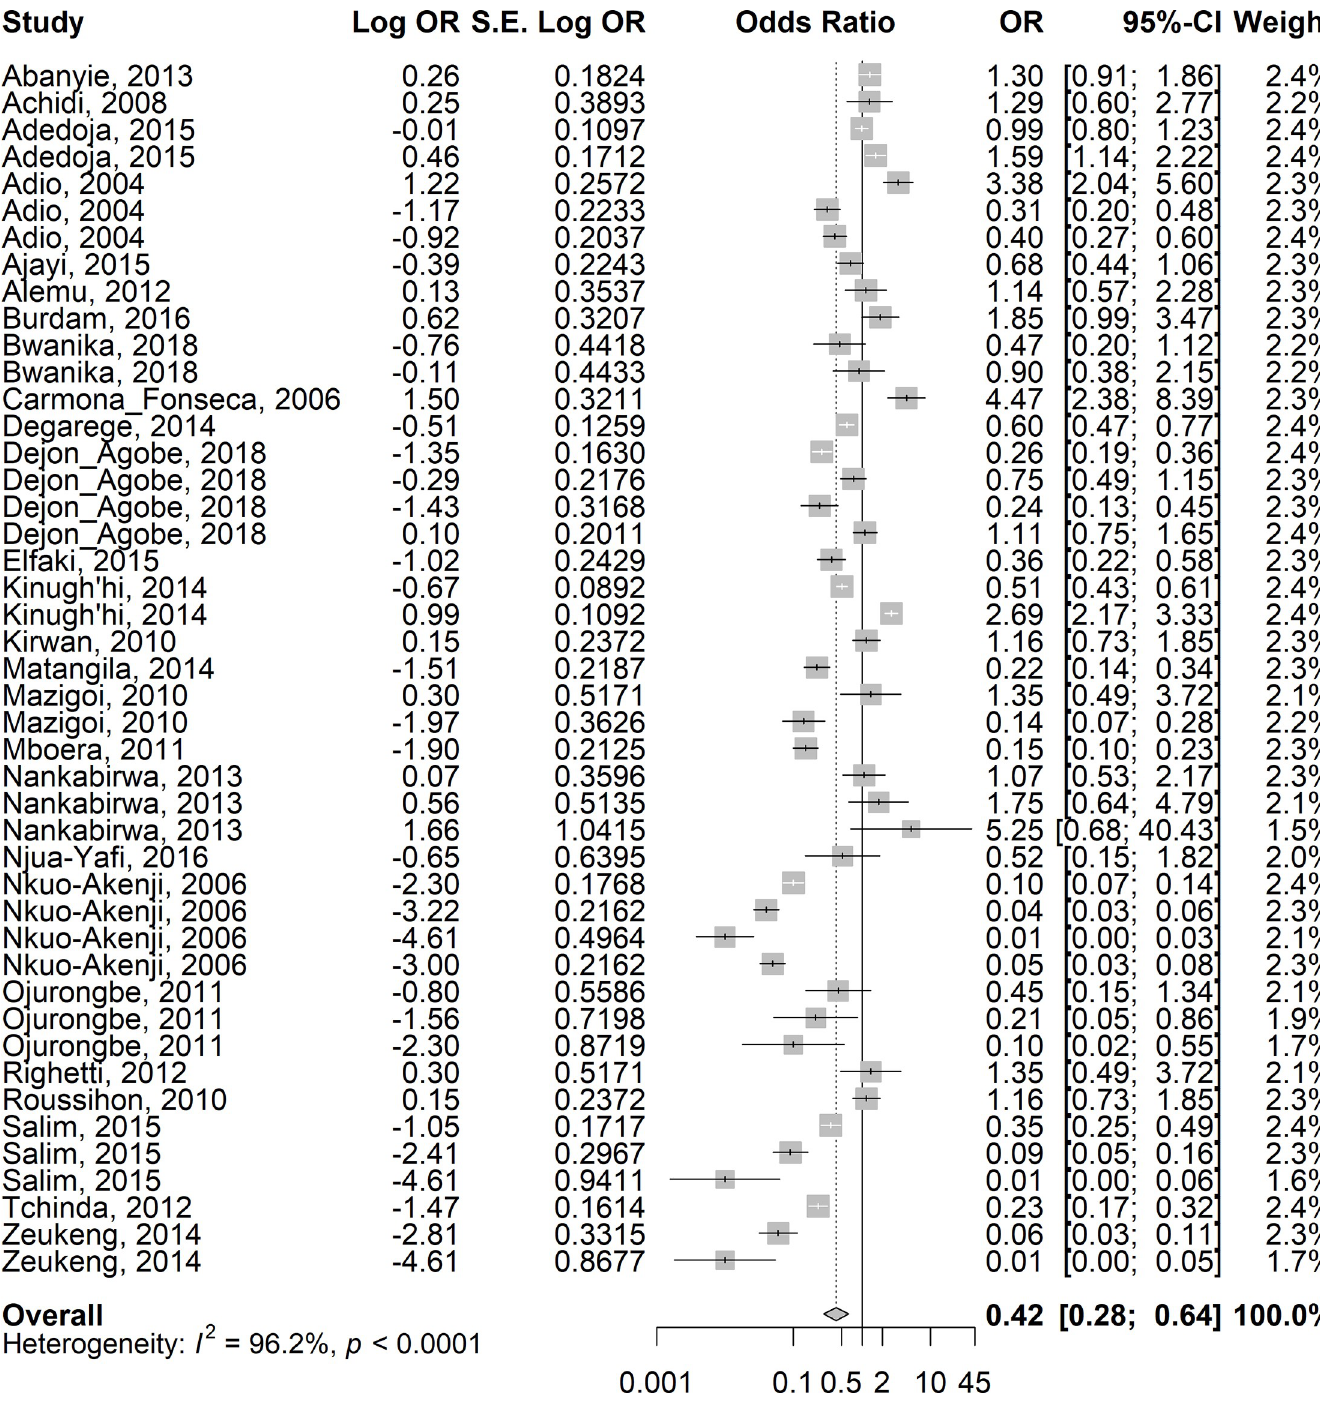
Fig 4. Forest plot showing the risk of asymptomatic/uncomplicated or severe P . falciparum infection in children co-infected with STH compared with children who did not have STH infection.